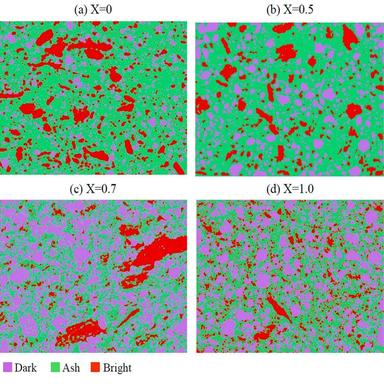
Color classified images of TiCXN1-X-TiCrNbMoTa composites (a) X = 0 (b) X = 0.5 (c) X = 0.7 (d) X = 1.0.